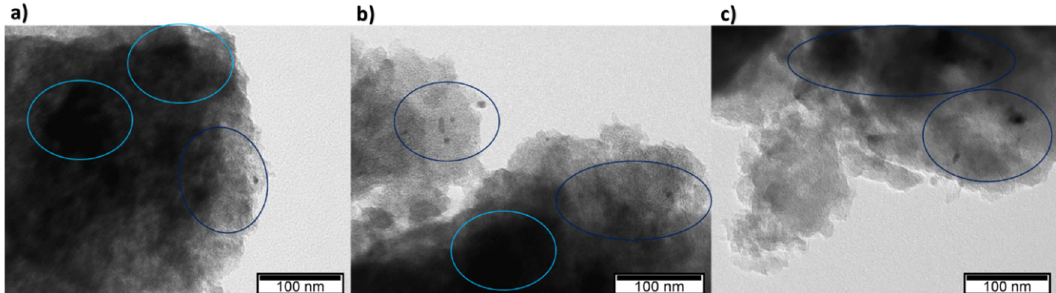
Figure 1. TEM images of AC-Pd1 ( a ), AC-Pd2 ( b ) and AC-Pt2 ( c ).